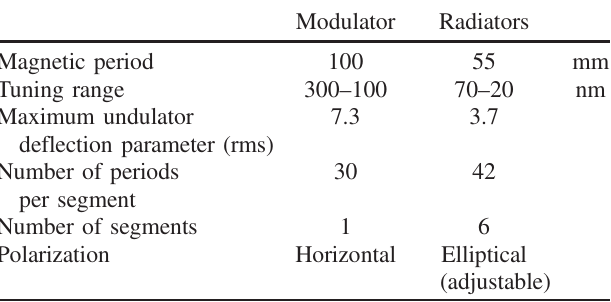
TABLE III. Main parameters for the FERMI FEL-1 undulators. The tuning range is estimated for the electron-beam energy used in the experiment, i.e., 1.2